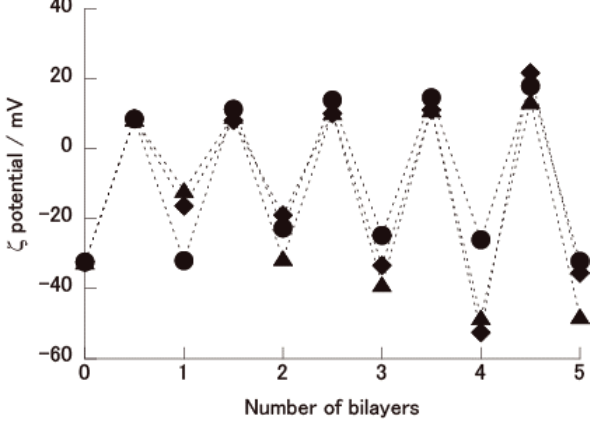
Figure 2. Typical ζ -potential of CaCO 3 particles coated with PAH/PSS ( ● ), PAH/PVS ( ▲ ), and PAH/DS ( ♦ ) films. The outermost is PSS, PVS, or DS when the number of bilayers is an